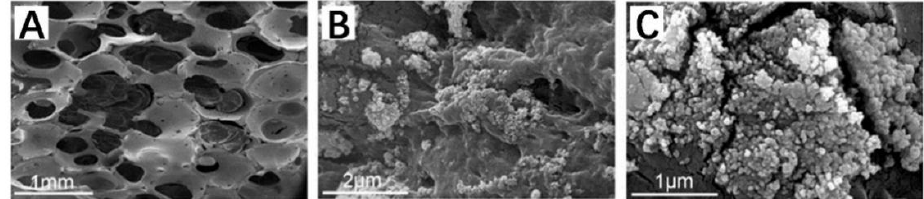
Figure 5. SEM images of the ZrO 2 – chitosan particles – GelMA composite scaffold . ( A ) ZrO 2 – chitosan particles – GelMA composite scaffold; ( B ) chitosan particles – GelMA inside the pores of scaffold; and ( C ) enlarged image of chitosan particles .